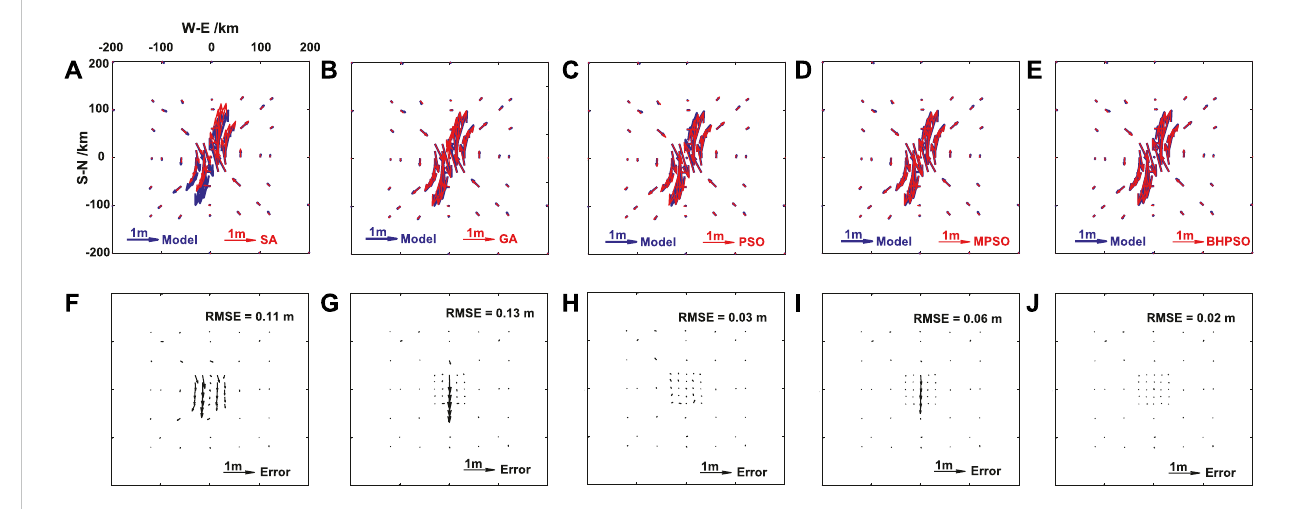
The comparisons of surface horizontal deformation (GPS data) of the Okada model results from the pure strike-slip fault earthquake by using fault parameters given by the model and inversed from fi ve methods in Table 1. The surface horizontal deformation obtained by model and SA method (A) , model and GA method (B) , model and PSO method (C) , model and MPSO method (D) , and model and BHPSO method (E) . The residual of surface horizontal deformation between the results of model and SA method (F) , model and GA method (G) , model and PSO method (H) , model and MPSO method (I) , model and BHPSO method (J) . The blue arrows show the simulated surface horizontal deformation by the model in Table 1. The red arrows show the simulated surface horizontal deformation by using the fault parameters inversed from the fi ve methods. The black arrows show the fi tting